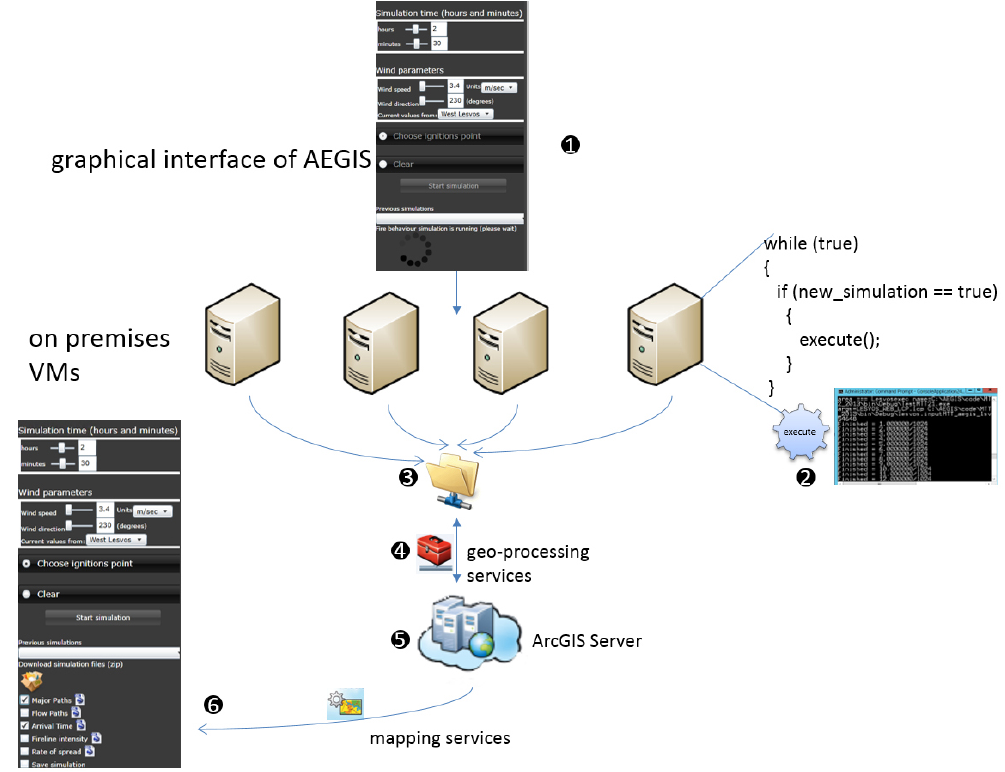
Figure 4. Information flow for on-demand MTT simulations of individual wildfires in